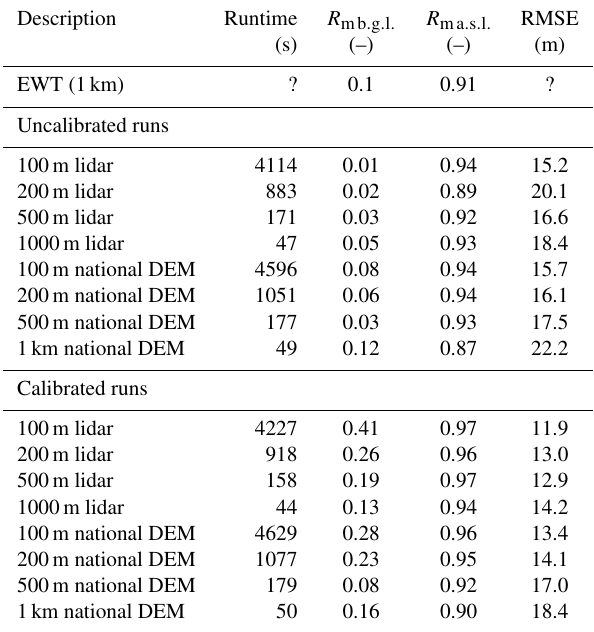
Table 3. Statistics on different model runs in the Waipa River catch- ment. RMSE stands for root mean square